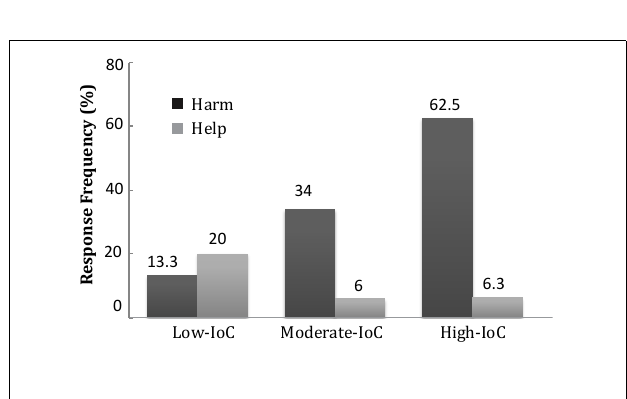
FIGURE 3 | Proportions of intention ascriptions for harmful (S–) and helpful (S+) by participants with different IoC levels.